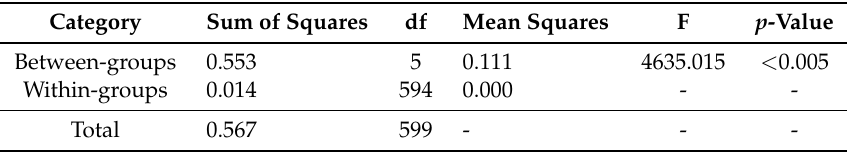
Table 2. One-way ANOVA